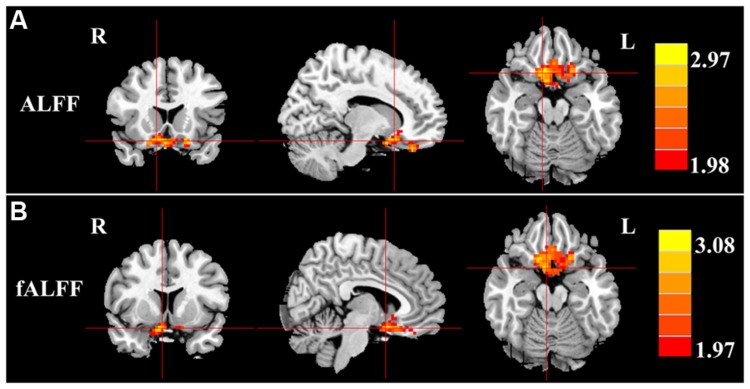
Interaction between frequency bands and tinnitus vs. control groups on (A) ALFF values and (B) fALFF values in the orbitofrontal gyrus. Red/hot colors identify brain regions where there was a significant interaction effect on ALFF (t-values 1.98 to 2.97; red to yellow, respectively) or fALFF (t-values 1.97 to 3.08; red to yellow, respectively). Results were obtained by a two-way repeated-measure ANOVA and post hoc test. AlphaSim corrected p < 0.05 (individual voxel thresholds p < 0.05 with a minimum cluster size of 3591 mm3).